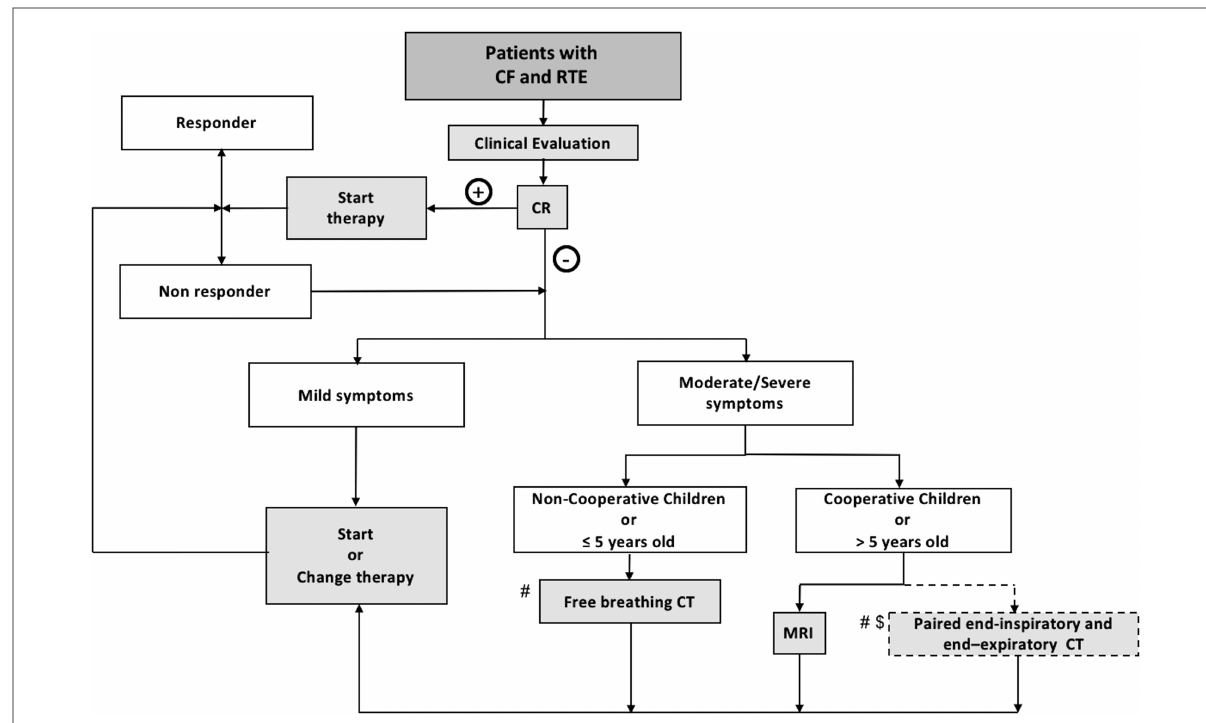
FIGURE 11 Work fl ow of the proposed imaging algorithm. CF, Cystic fi brosis; CR, Chest Radiography; CT, computed tomography; MRI, magnetic resonance imaging; RTE: respiratory tract exacerbation; # recent CT or MRI not available (<2 years); $, center with no MRI or no MRI experience; +, positive CR fi ndings; − , negative CR fi